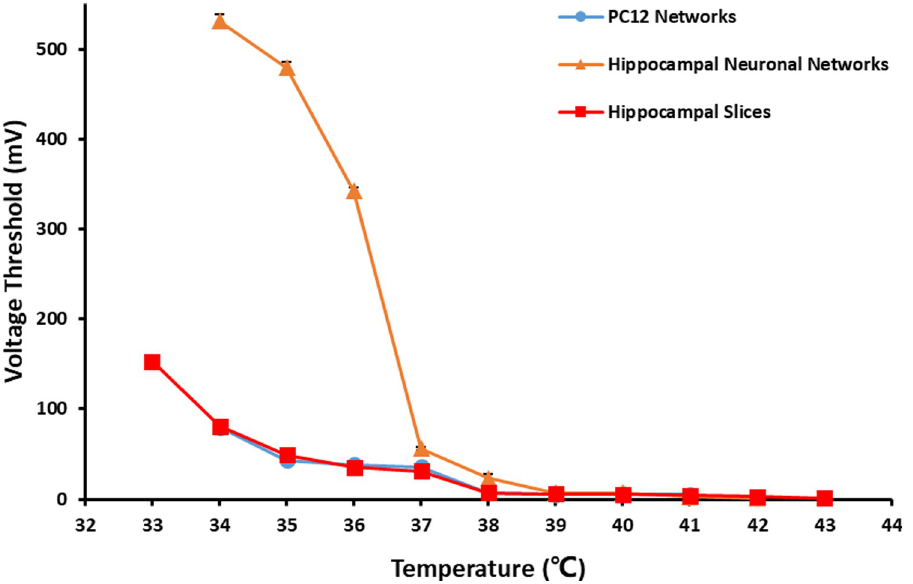
Fig 9. The changes of V Th of the three types of neuronal networks with temperature ( n = 5).